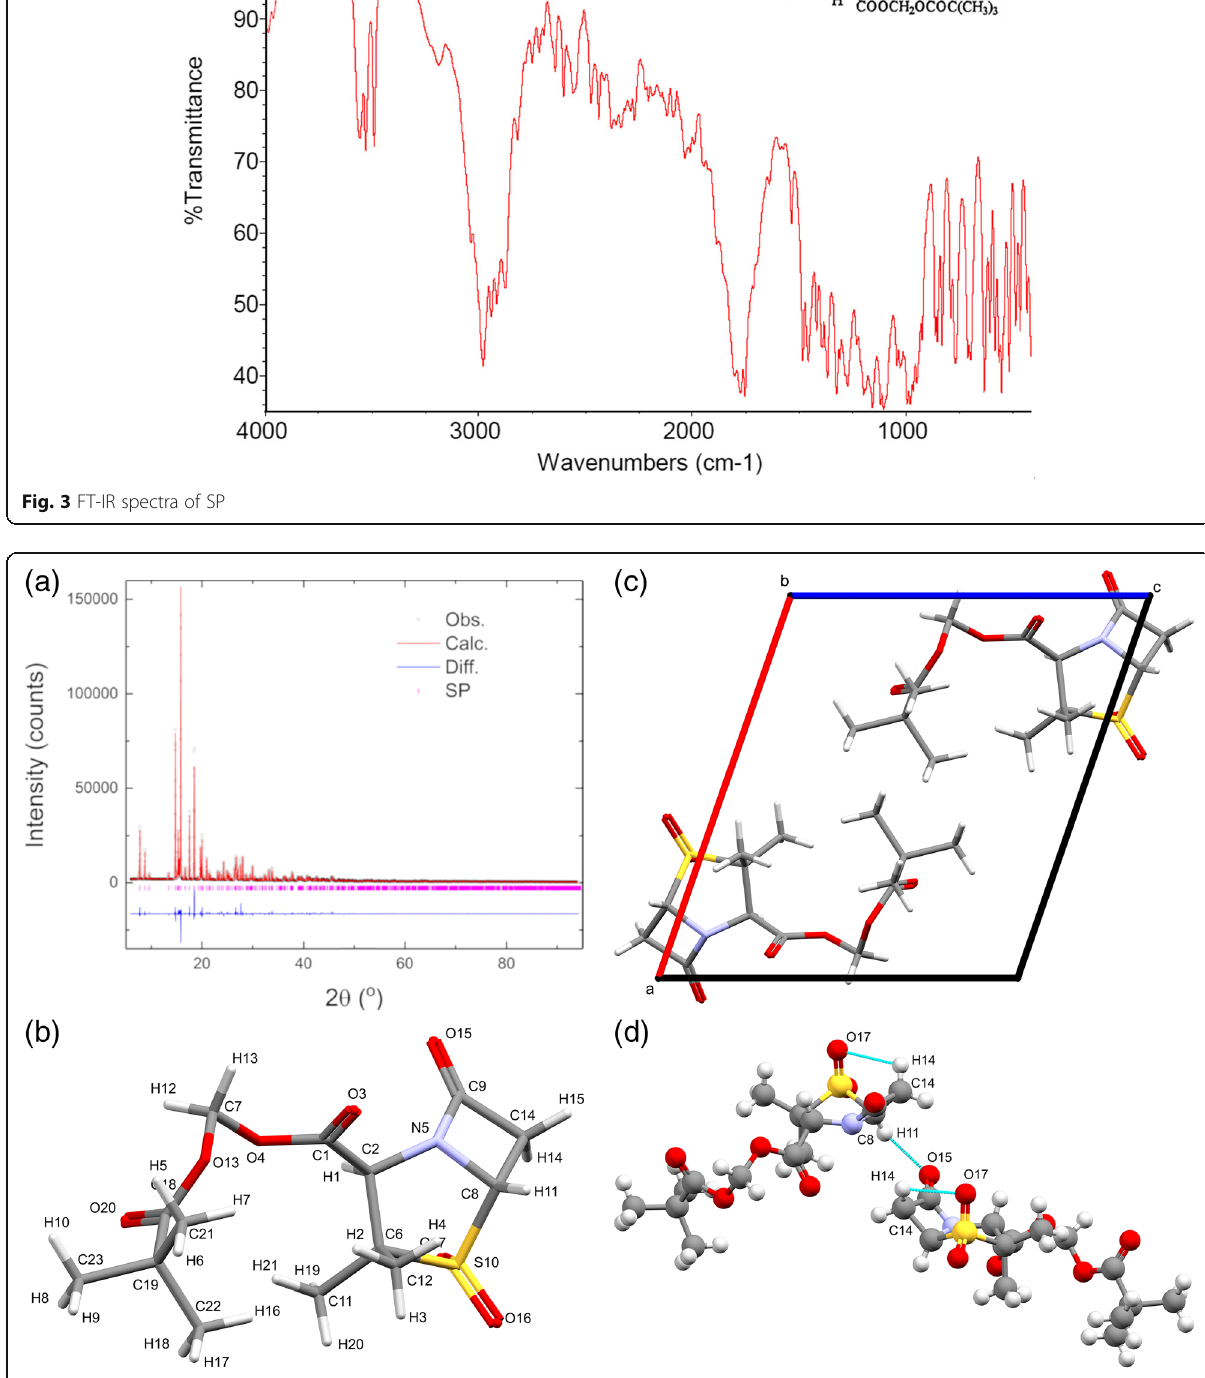
Fig. 4 a Rietveld plot of SP. The black circles represent the observed data while the red curve indicates the calculated pattern. The blue line at the bottom stands for the difference between the observed and calculated data. The vertical bars (magenta) represent the Bragg reflections. b Asymmetric unit displaying the atoms labeling. c Unit cell packing. d Intra and intermolecular hydrogen bonds (cyan